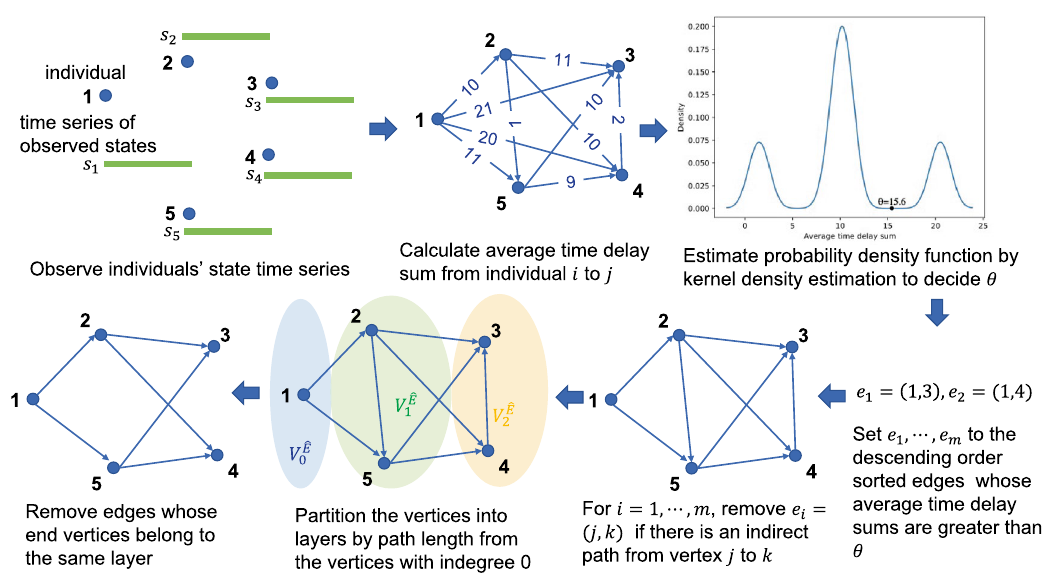
Figure 1. Summary diagram of our method with a toy